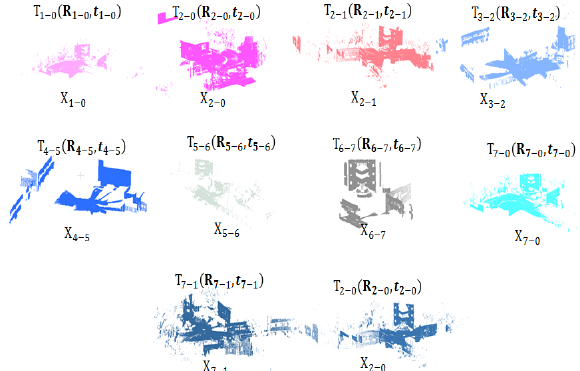
Figure 6. Pairs of point clouds used in the pose-graph optimization.